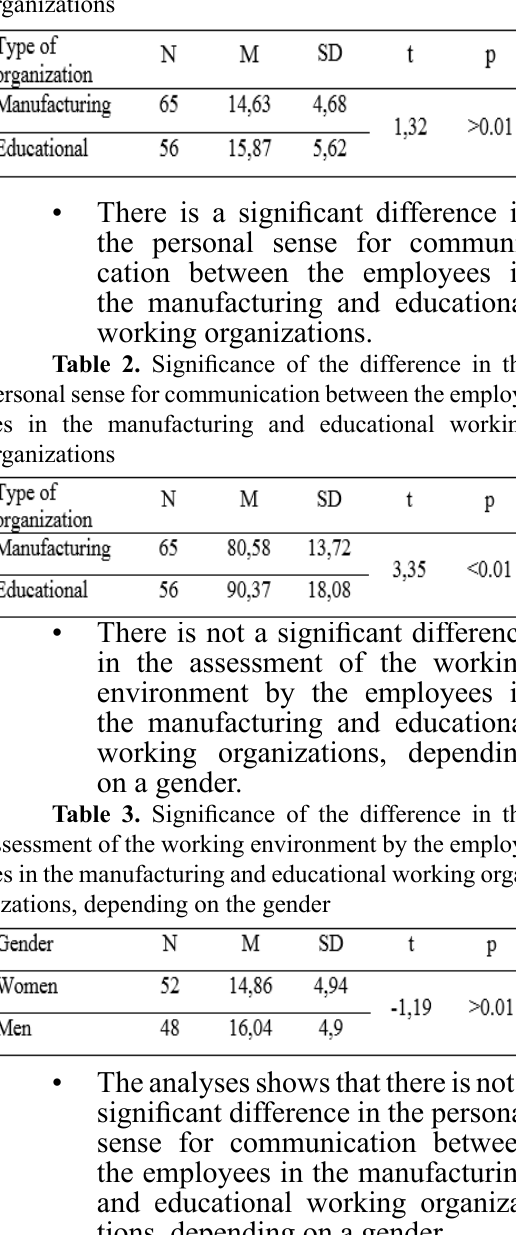
Table 1. Significance of the difference in the assessment of the working environment by the employ -